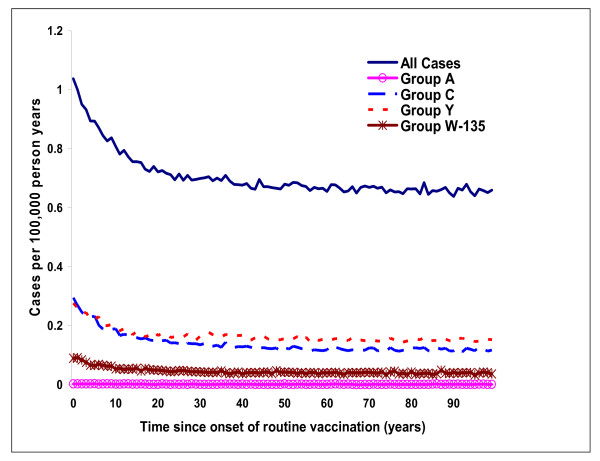
Incidence of meningococcal disease (total and vaccine preventable) over 100 years following initiation of routine vaccination of 12 year olds.